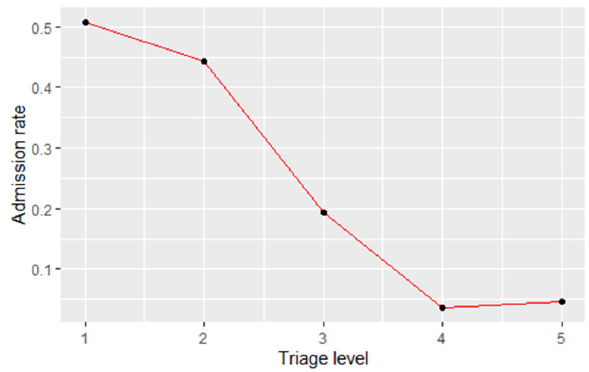
Figure 7. Admission frequency per triage level.